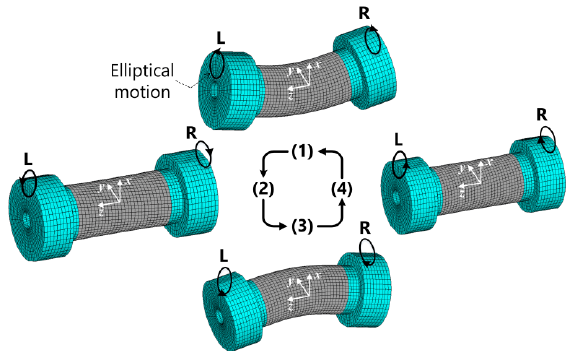
Table 1. Vibration velocities and vibration displacements at different time. Vibration Velocity Time Point